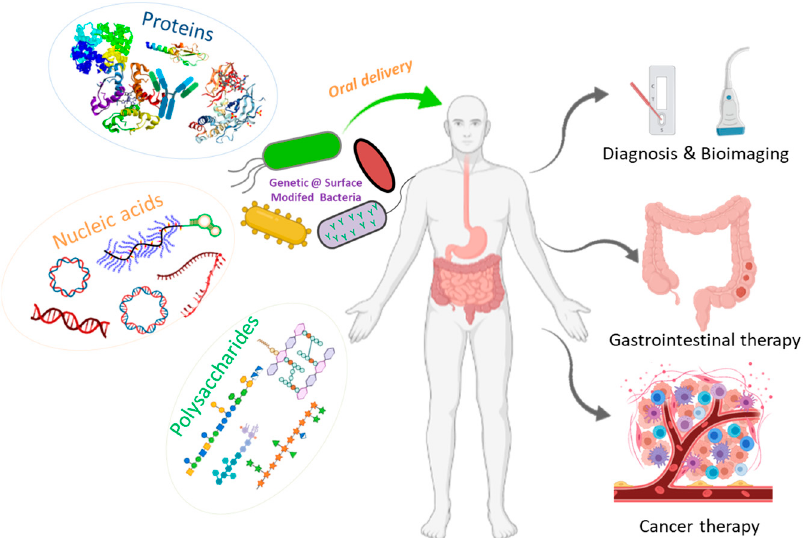
Figure 1. Schematic illustration of the oral delivery of therapeutic biomacromolecules by bacteria-based microdevices for disease diagnosis and treatment.